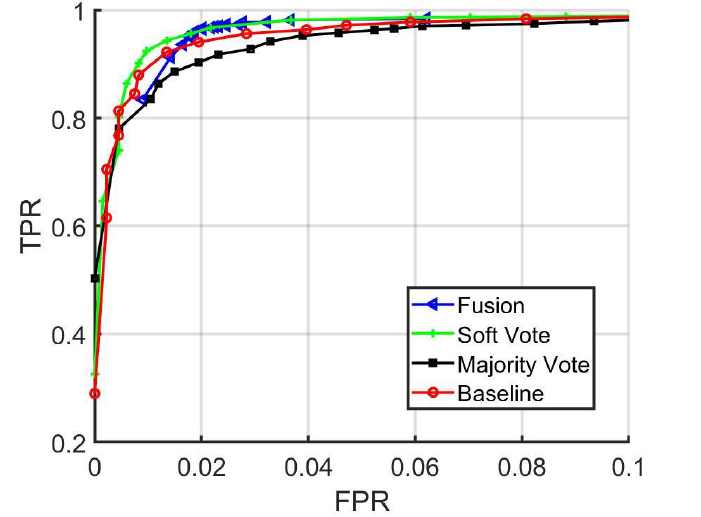
Figure 19. Baseline, majority vote, soft vote, and fusion network ROC